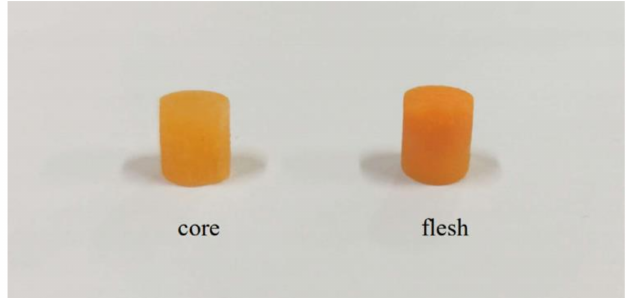
Figure 2. Cylinder samples of the carrot.